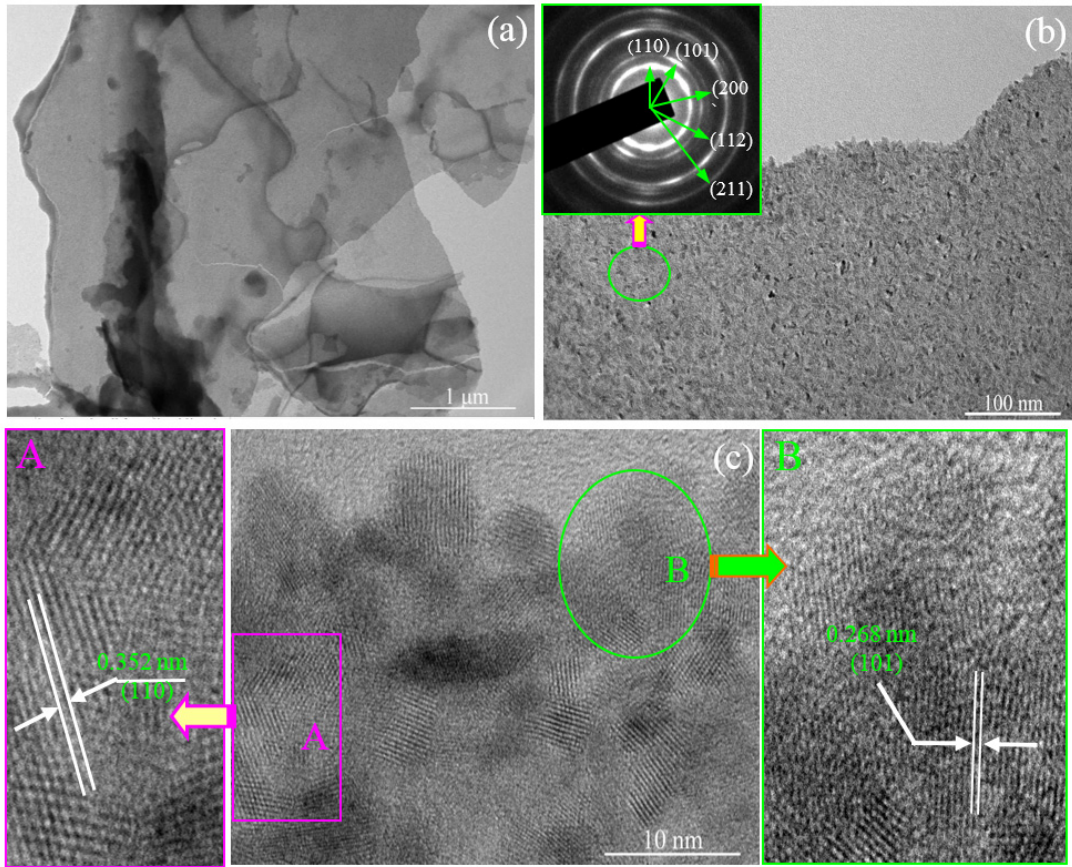
Figure 4. TEM images of the as-prepared SnO 2 nanosheets. ( a ) Low-magnification TEM image; ( b ) High-magnification TEM image. Inset: the image of selected area electron diffraction; ( c ) Lattice-revolved HRTEM image. The further enlarge HRTEM image of the marked area A and B showing the interplanar spacing of SnO 2 nanoparticles with the (110) and (101) crystal face.